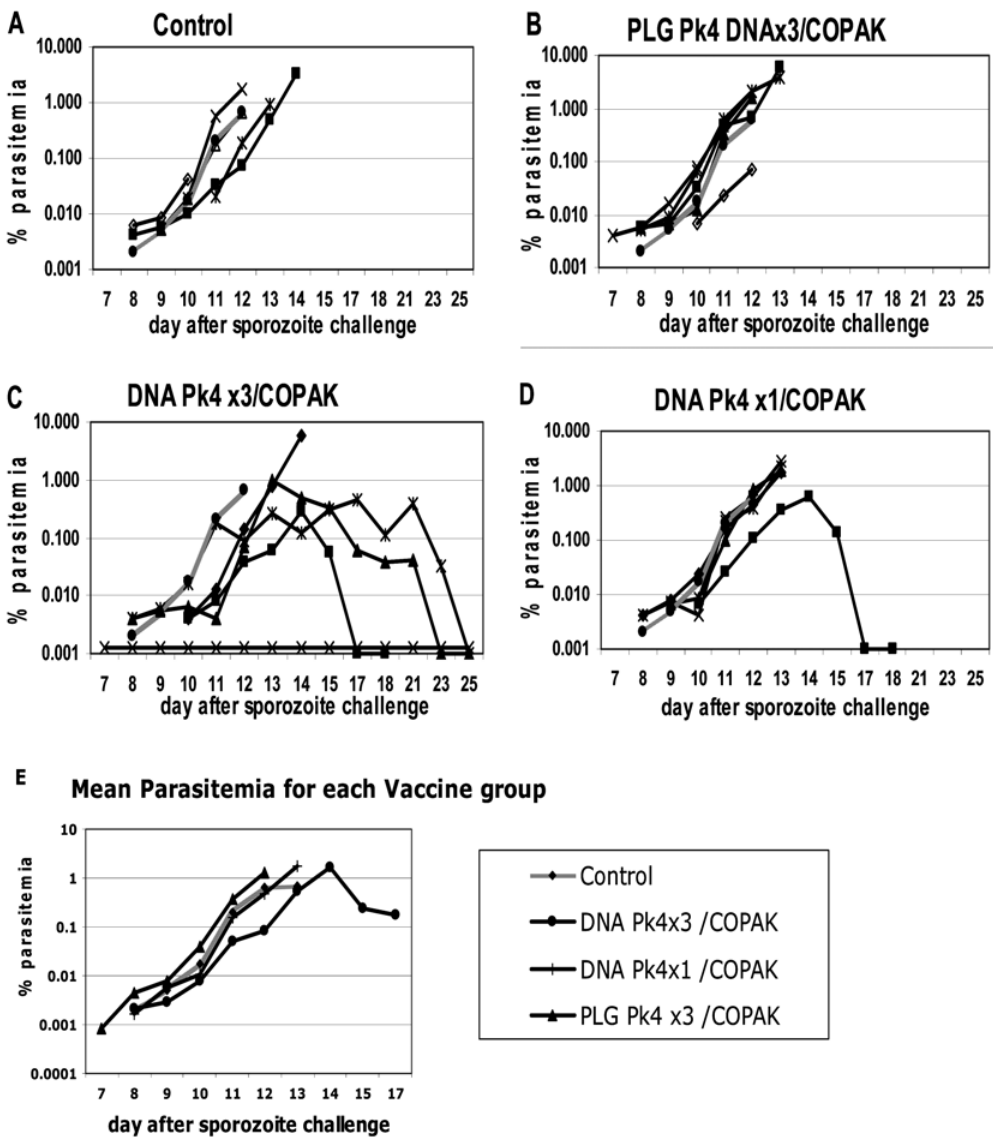
Figure 1. Panels A–D show the % parasitemia for individual monkeys by vaccine group according to the day after sporozoite challenge for Experiment # 1. Data shows the first day parasites were detected and continues until the animal was drug treated when parasitemia exceeded 1% ( 3 animals inadvertently treated at lower parasitemias have open symbols). For comparison, in each panel the grey line shows the mean parasitemia for the Control group. In panel C, one animal never became parasitemic as indicated by x-x. Panel E shows the geometric mean parasitemias for vaccine groups for all days in which at least three animals had not been drug treated. (The monkey from the DNA Pk4 6 3/COPAK group which did not become infected was excluded from the